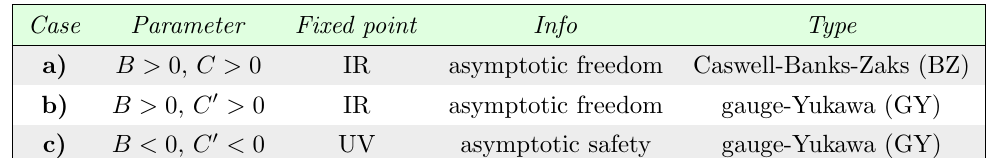
Table 1 . All weakly interacting (cid:12)xed points (cid:11) dependence on the matter content expressed through the parameters B; C and C 0 , see